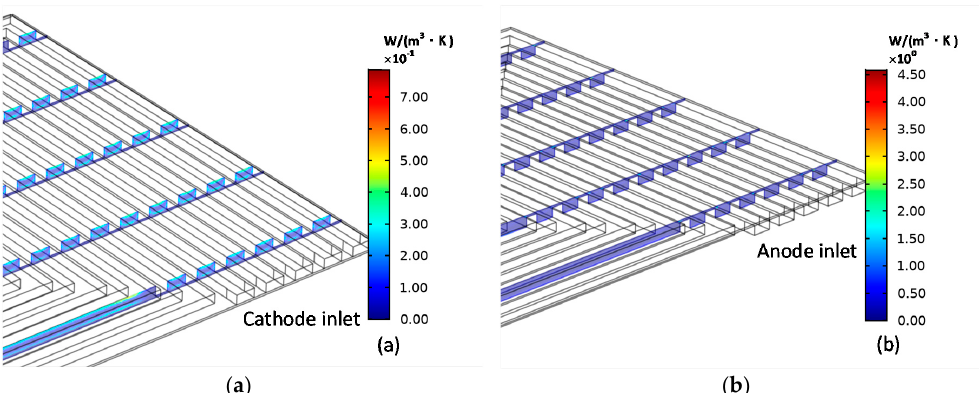
Figure 4. Cathode ( a ) entropy production and anode ( b ) entropy production caused by fluid friction.